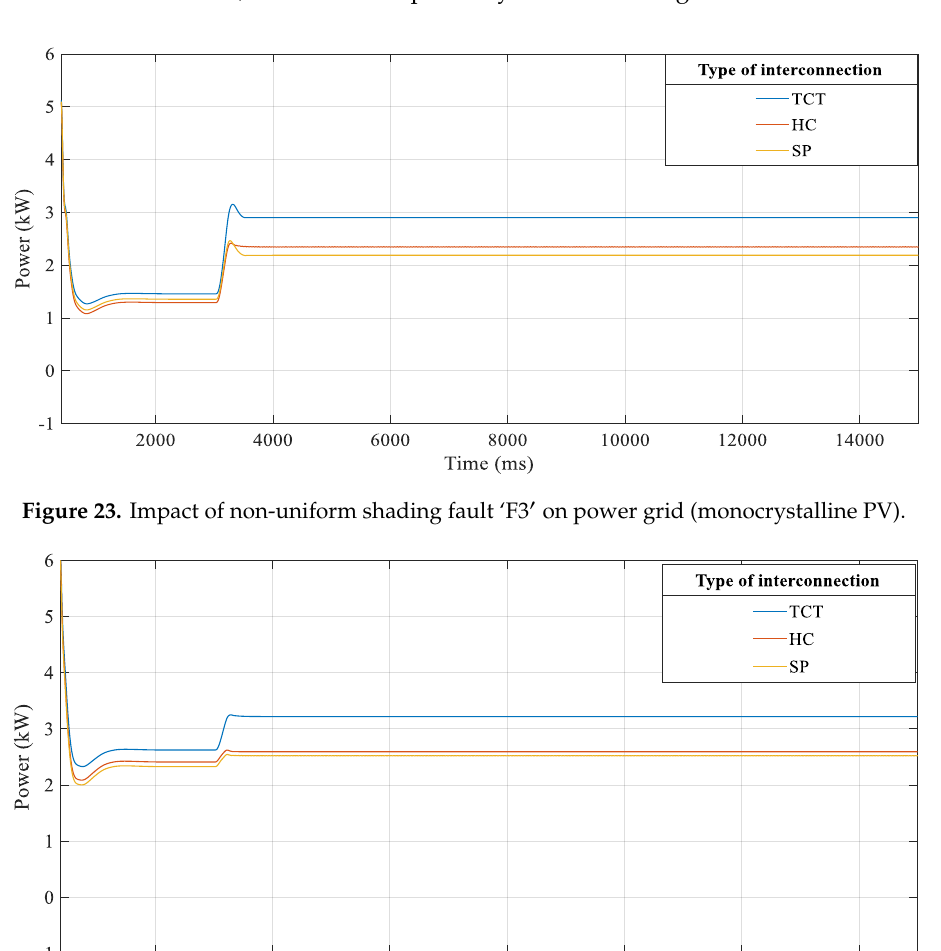
18 of 25 Figure 21. Impact of short- circuit fault ‘F2′ on power grid (monocrystalline PV).